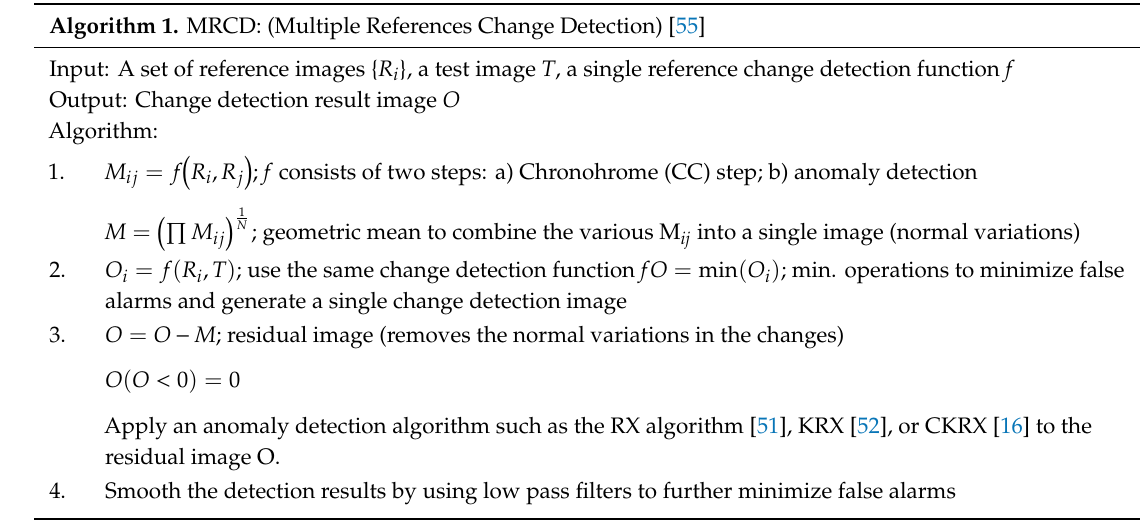
Algorithm 1. MRCD: (Multiple References Change Detection) [55]